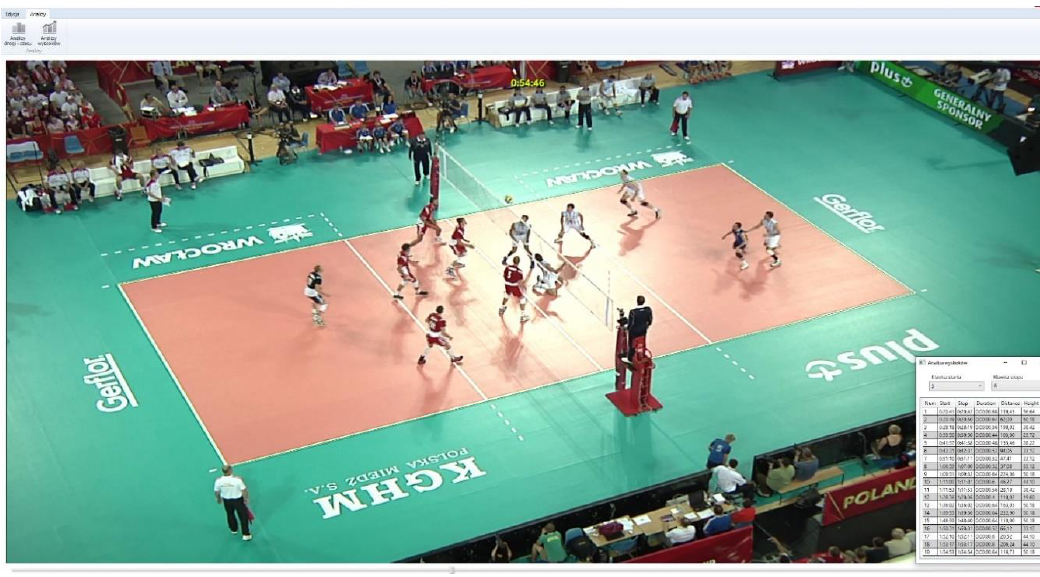
Figure 1. Software analysis on jump serve height (SJH), attack jump height (AJH), block jump height (BJH) (shift of a volleyball player’s center of gravity in a vertical position), and jumping flying distance (JFD).